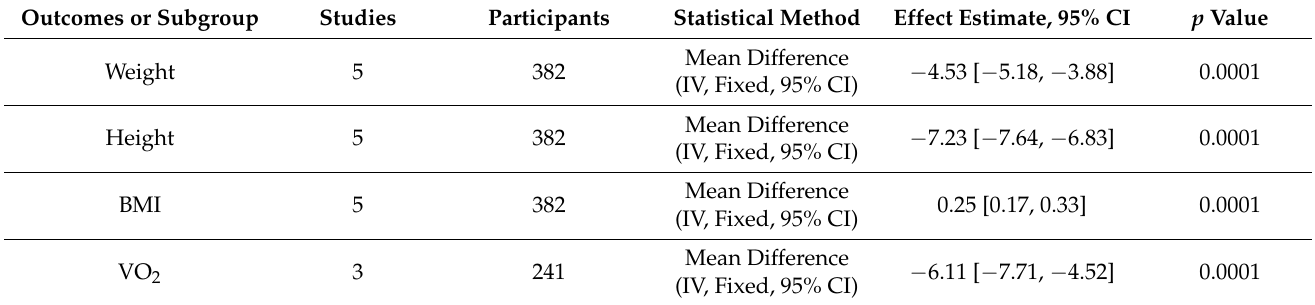
Table 3. Difference in physical fitness variables between HIV group vs. healthy group. Outcomes or